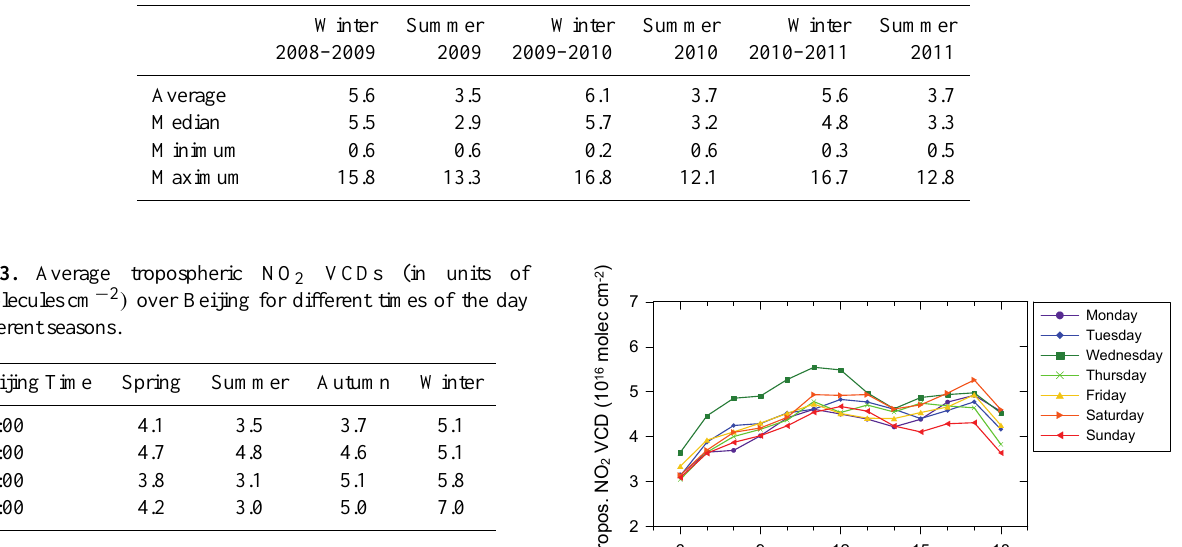
the years of 2008, 2009, 2010 and 2011. It is shown clearly that the tropospheric NO 2 VCDs were much smaller in 2008 than in other years, especially in the morning and early after- noon. The most significant difference occurred at 11:00 BJT, when the daily maximum of the tropospheric NO 2 VCDs took place in each year. In the late afternoon, the effects of the emission control measures are much less obvious in the NO 2 VCDs. Table 4 lists the tropospheric NO 2 VCD values at selected times of the day in August, as well as the relative reductions (in percent) of the 2008 values compared to 2009, 2010 and 2011, respectively. Based on our measurements in the morning and early afternoon, the decreases in the tro- Games are estimated to be 39–54 %, with respect to the fol- lowing years of 2009, 2010 and 2011, respectively. Note